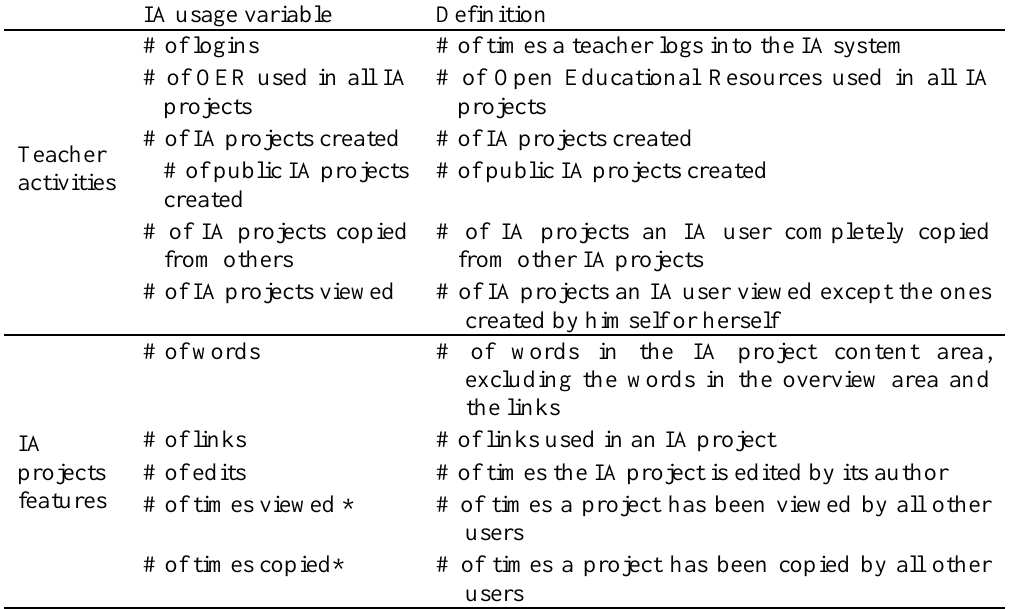
Definition of IA Usage